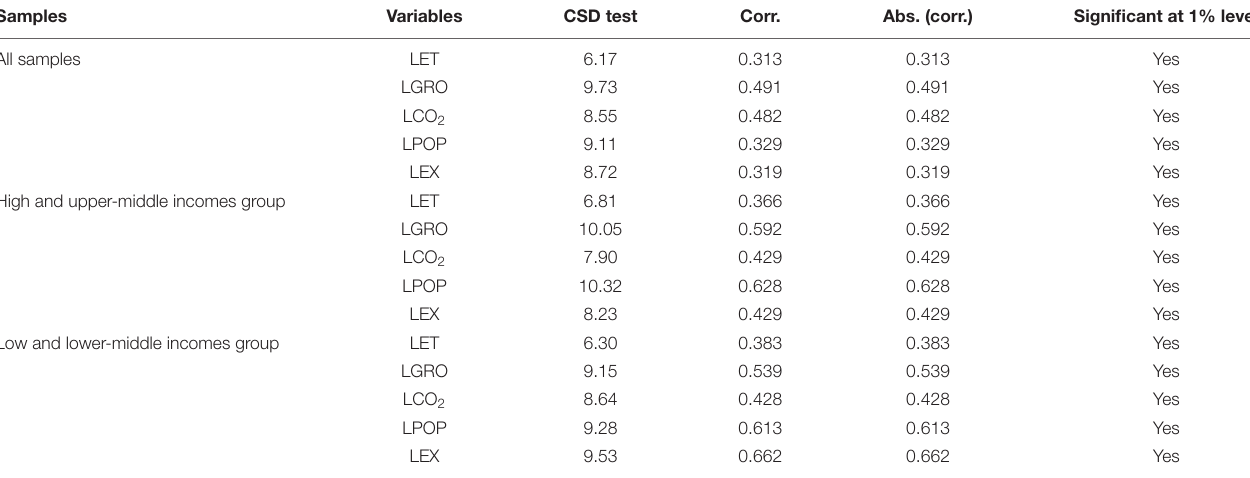
TABLE 4 | Cross-sectional dependence test results. Samples